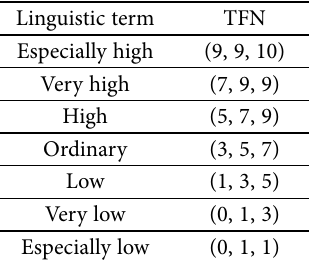
Table 4. Linguistic terms for attribute weights